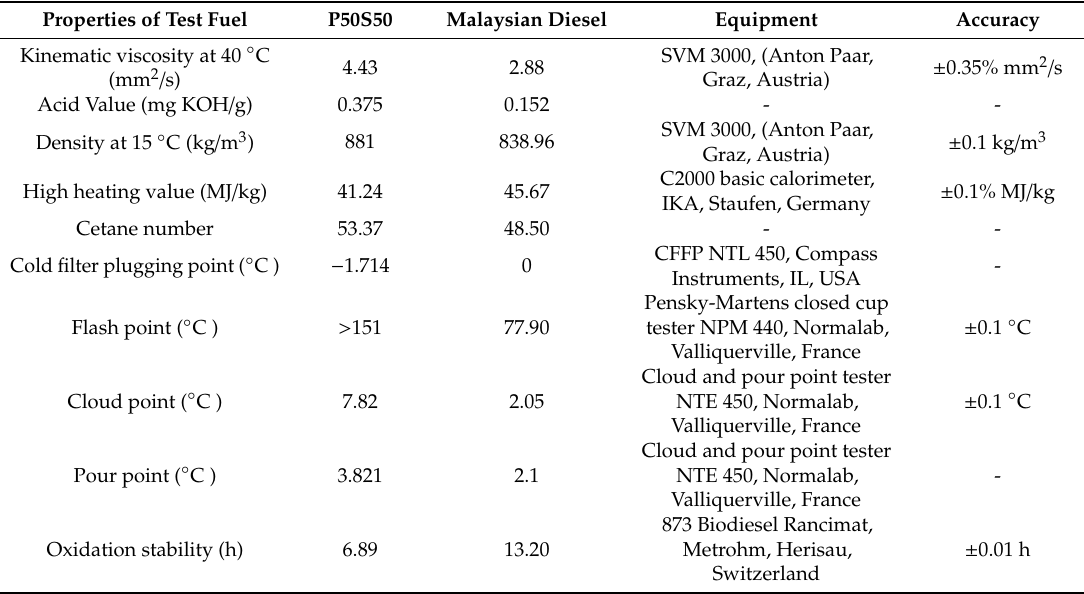
Table 1. Physicochemical properties of P50S50 biodiesel.